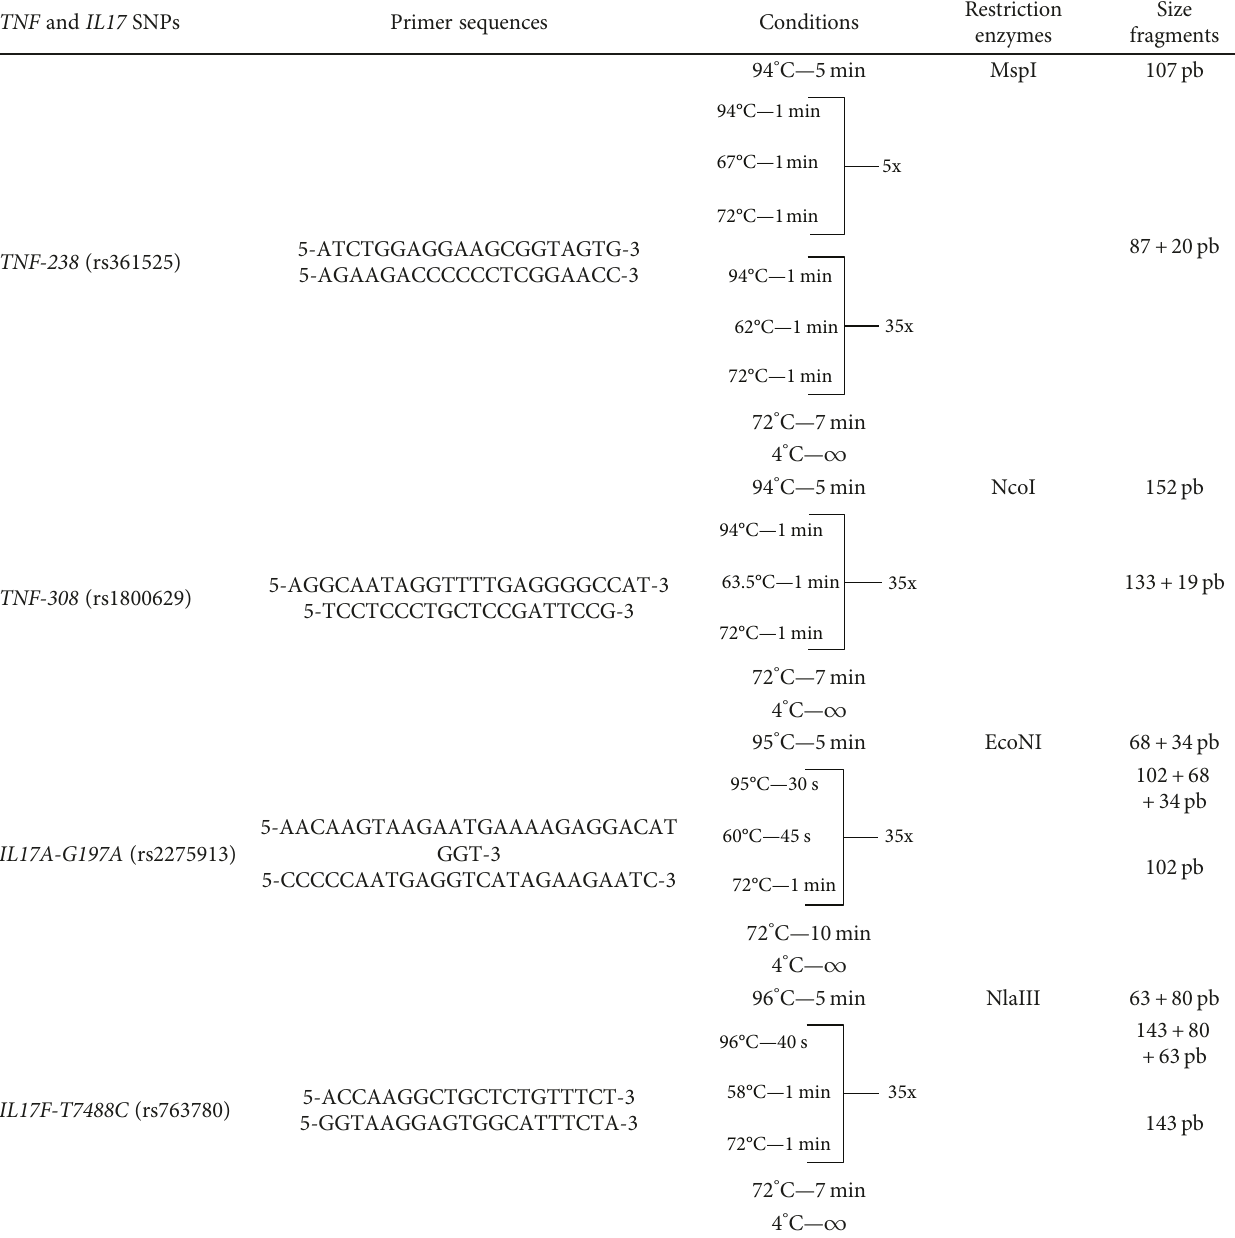
Table 1: Primer sequences, conditions, restriction enzymes, and size fragments.